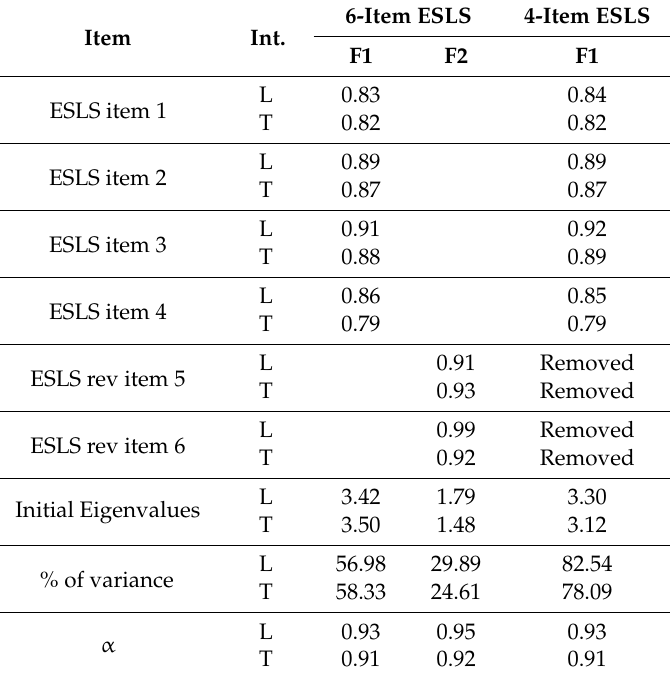
Table 3. Factor loadings, eigenvalues, and alpha coefficients for six- and four-item versions of the light ( n = 410; varimax rotation; rotated factor matrix loadings) and tiring ( n = 610; direct oblimin rotation; pattern matrix loadings) physical activity versions of the ESLS. 6-Item ESLS 4-Item Item Int.